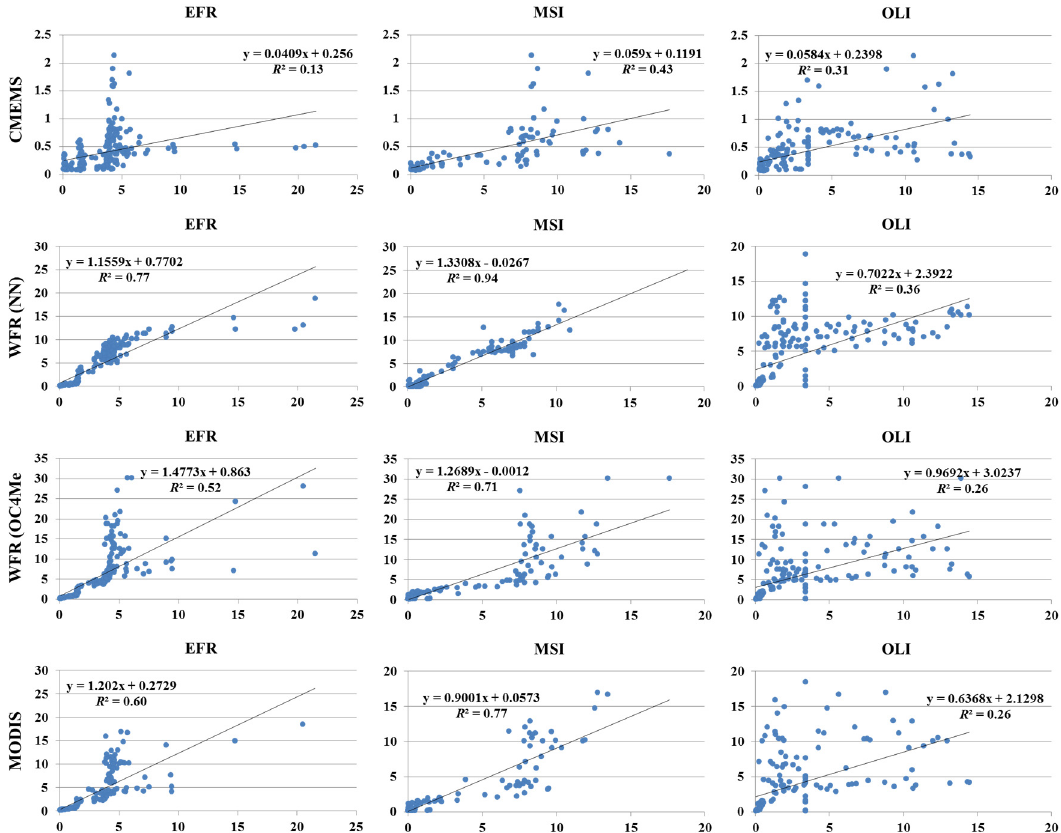
Figure 6. Regression analysis of the Chl- a contents estimated from the EFR, MSI, and OLI against the reference standard CMEMS, WFR, and MODIS chlorophyll- a contents.